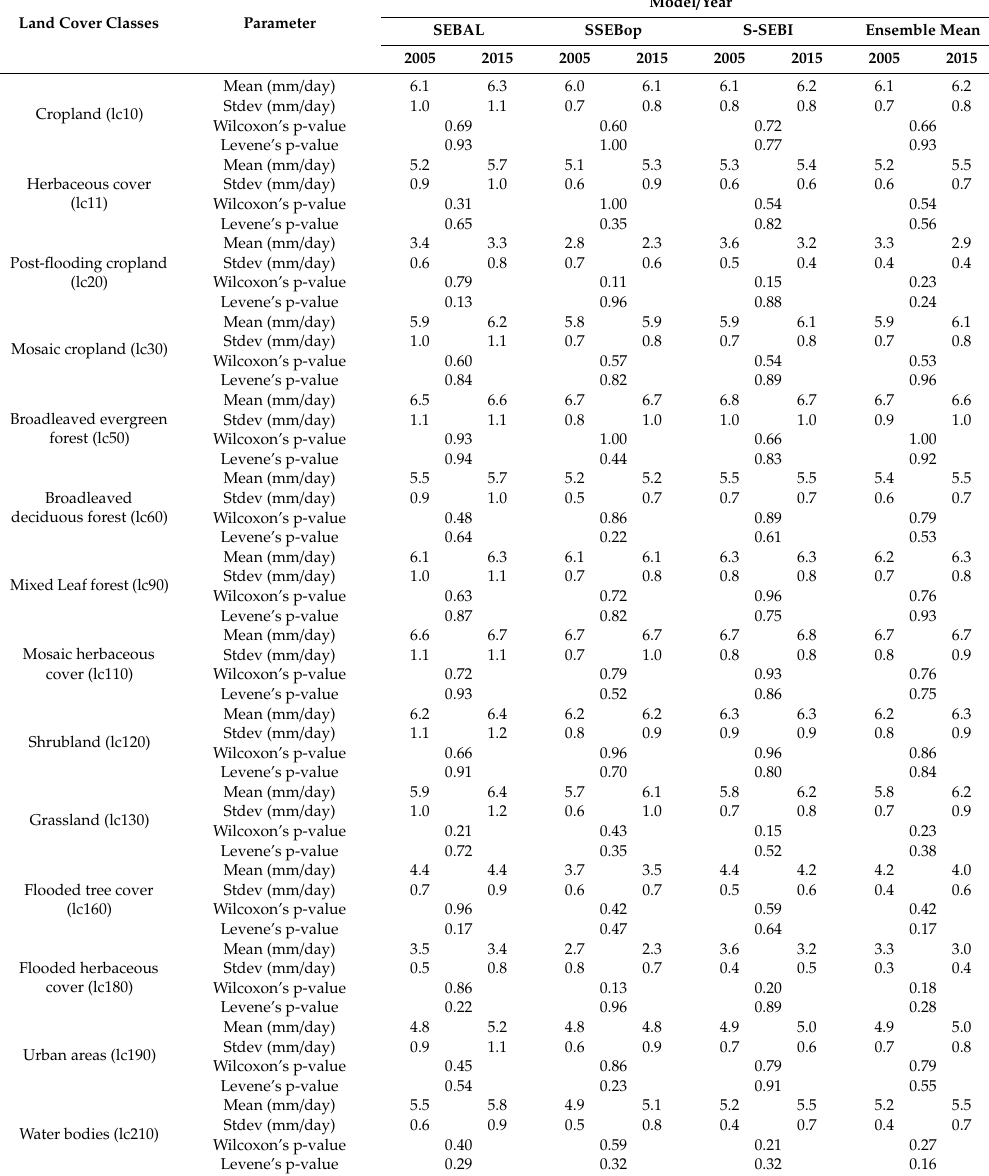
Table 10. The comparison of daily evapotranspiration (ET) (computed using Surface Energy Balance (SEB) models) for di ff erent land cover classes in the Kilombero Valley (KV) river basin between 2005 (five years before implementation of SAGCOT initiative) and 2015 (five years after implementation of SAGCOT initiative) for 9 common MODIS satellite overpasses (i.e., 9 MODIS images in 2005 and 9 MODIS images in 2015). SAGCOT, Southern Agricultural Corridor of Tanzania; SEBAL, Surface Energy Balance Algorithm for Land; SSEBop, Operational Simplified Surface Energy Balance Algorithm; S-SEBI, Simplified Surface Energy Balance Index, Ensemble mean, the mean of daily ET estimates from the three models; Stdev, sample standard deviation.